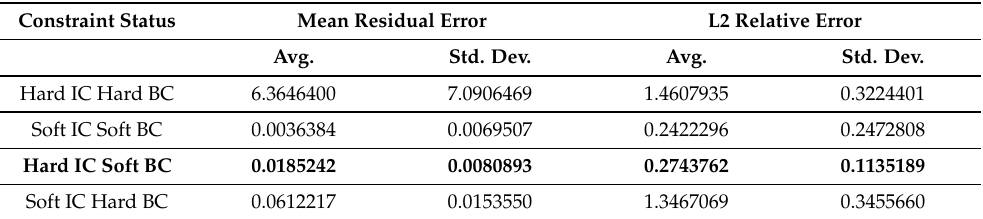
Table 3. Error evaluation of using the best-tested set of hyperparameters for a hard IC constraint and soft BC constraint (hard–soft) model.